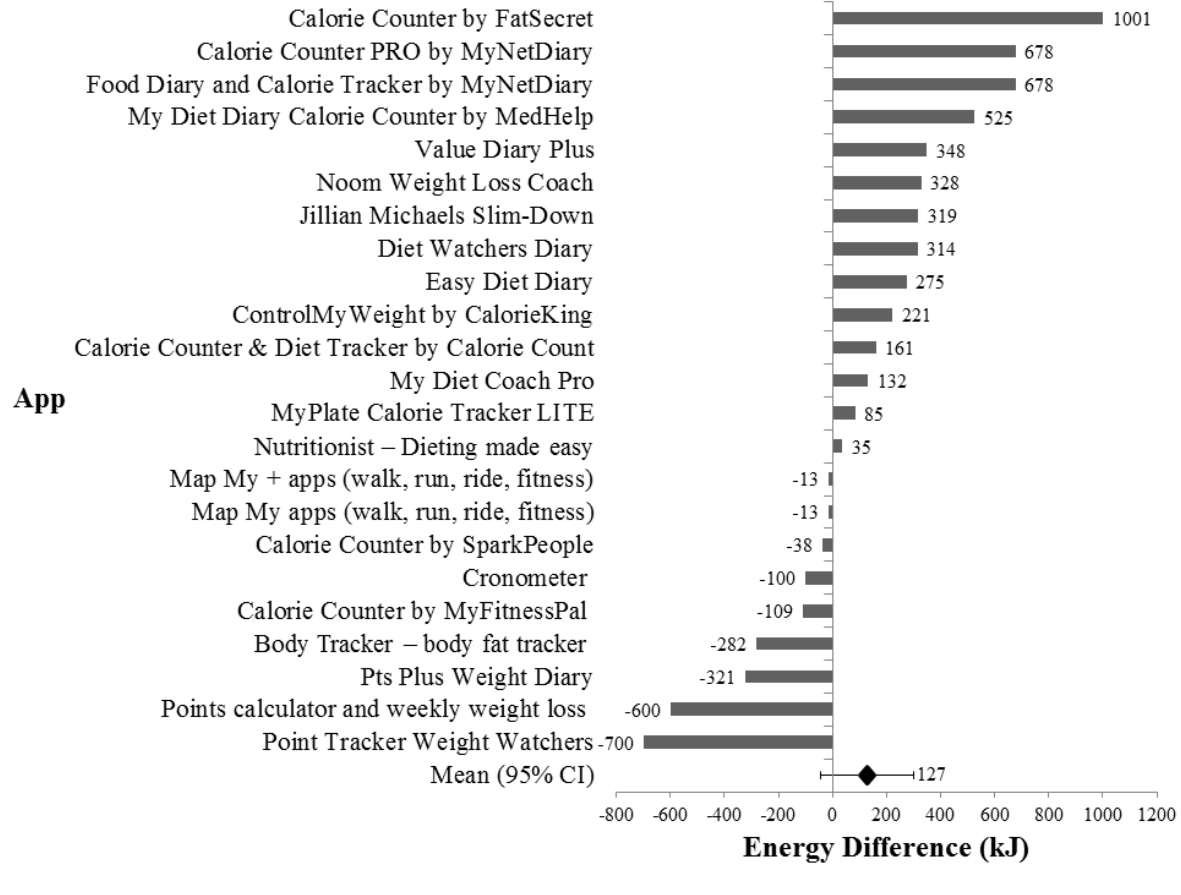
Figure 4. Accuracy of dietary apps compared to the weighed food record (WFR). Differences in mean energy intake values (kJ) over 3 days for dietary apps (n=23) were compared against the 3-day WFRs analyzed on FoodWorks. The overall mean difference of all the apps from the WFRs is denoted by the black diamond, and the 95% CI is indicated by the error